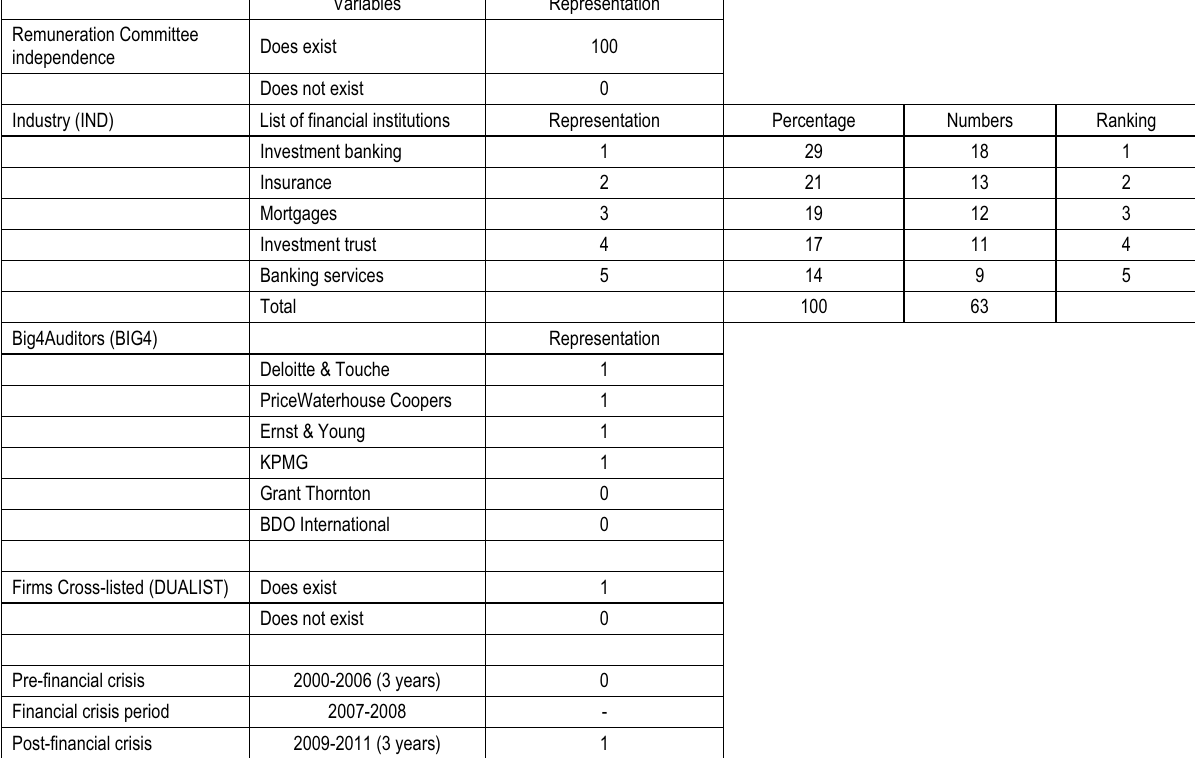
Table 1. Classification and representation of